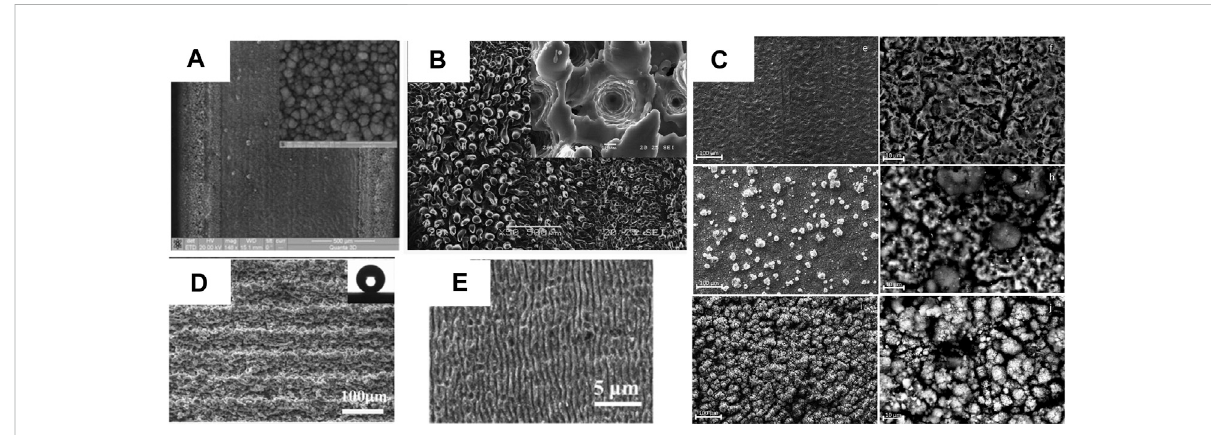
FIGURE 5 Surface morphologies. (A) AZ31B alloy surface after irradiation with progressive laser power of 110 W and high magni fi cation images from the areas (Guan et al., 2013b); (B) Laser-induced craters by nanosecond pulsed Nd: YAG laser irradiation (Guan et al., 2014a); (C) the laser structure of AZ31 (Demir et al., 2014); (D) superhydrophobic AZ91 (Wei et al., 2019); (E) laser melted and LIPSS (Zhang et al., 2019a).